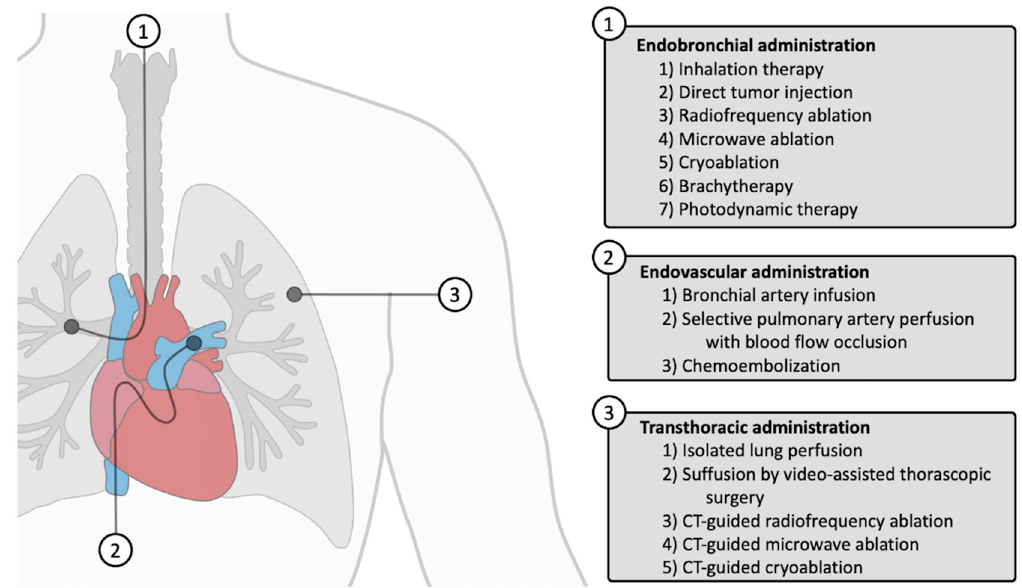
Figure 1. Overview of the loco-regional techniques based on their route of administration.